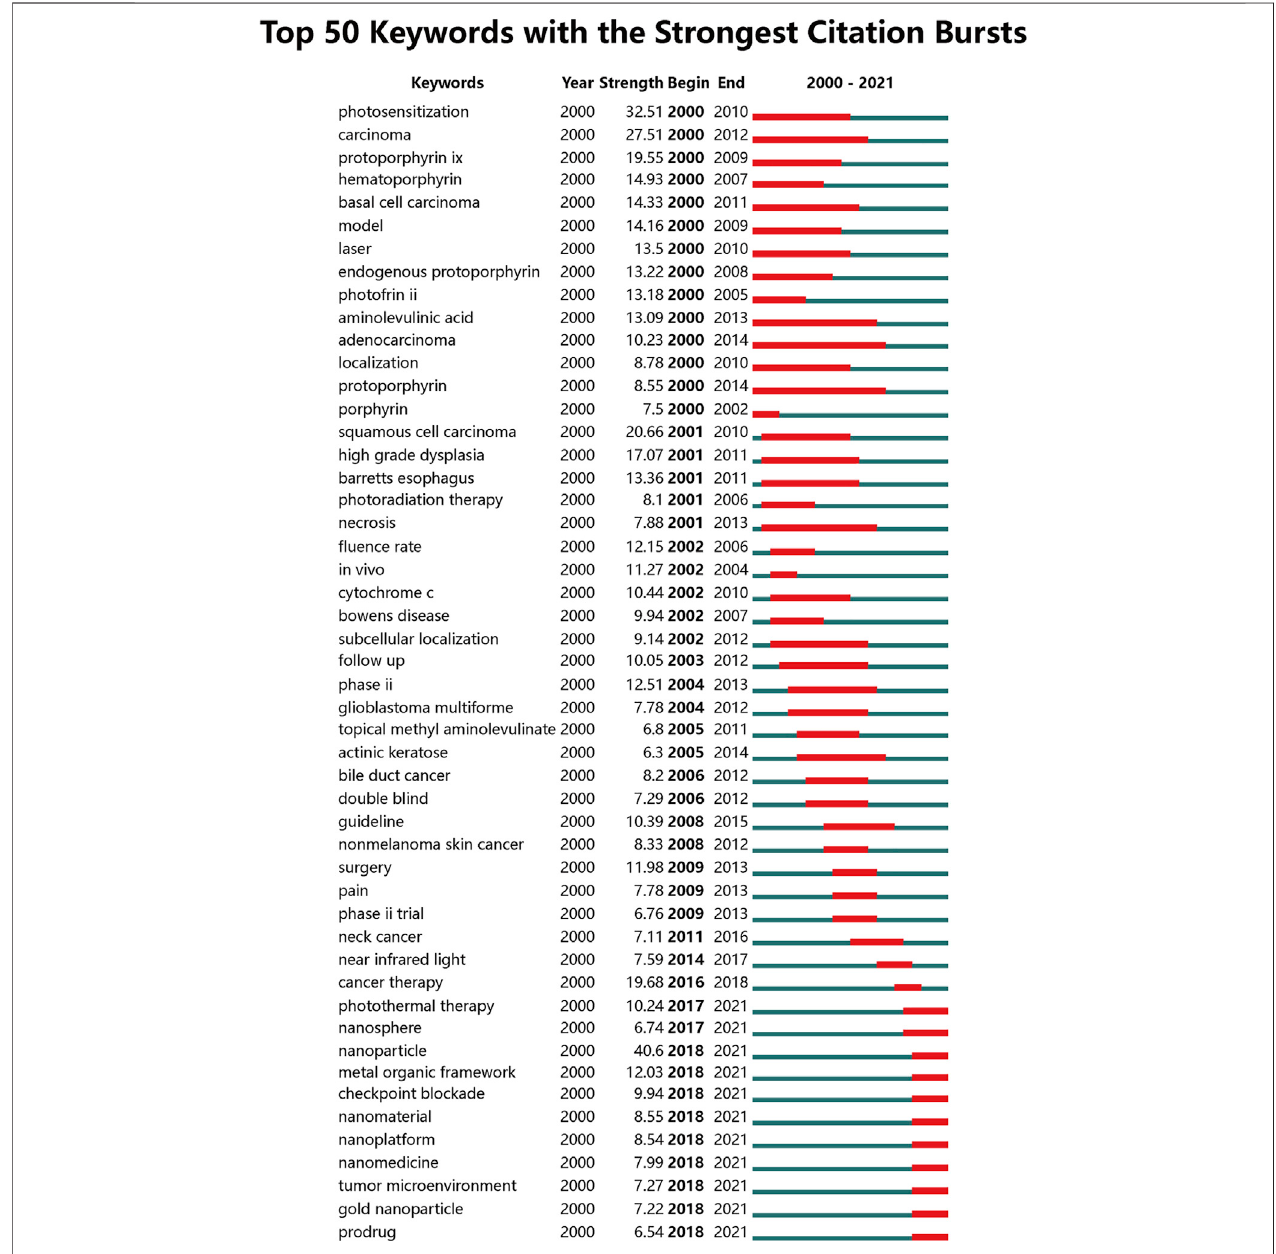
FIGURE 8 | Top 50 keywords with the strongest citation bursts by CiteSpace. A blue line indicates the timeline, and the bars in red stands for a burst period including the beginning year, the end year, and the burst duration of the keywords.